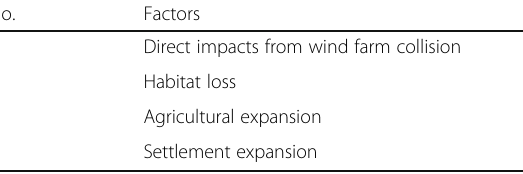
Table 2 Factors that affect birds and bats in and around the wind farm